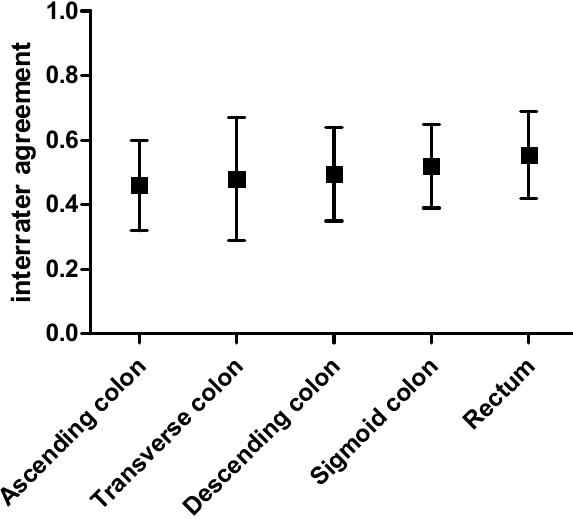
Figure 1. Inter-rater agreement on Extended Mayo Endoscopic Score (EMES) for each colon segment. Kappa values and 95% CI are Endoscopic evaluations according to EMES for each parameter of every colic segment showed